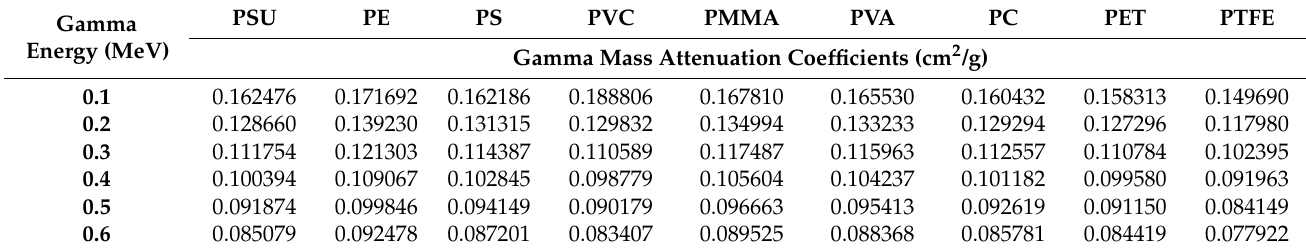
Table 9. Gamma mass attenuation coefficients of different polymers compared to